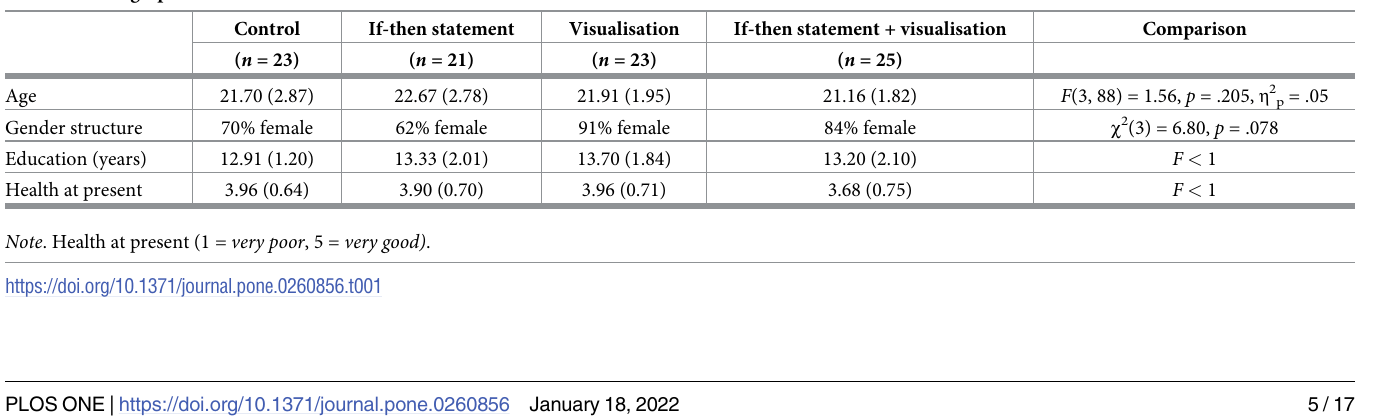
Table 1. Demographic characteristics as a function of